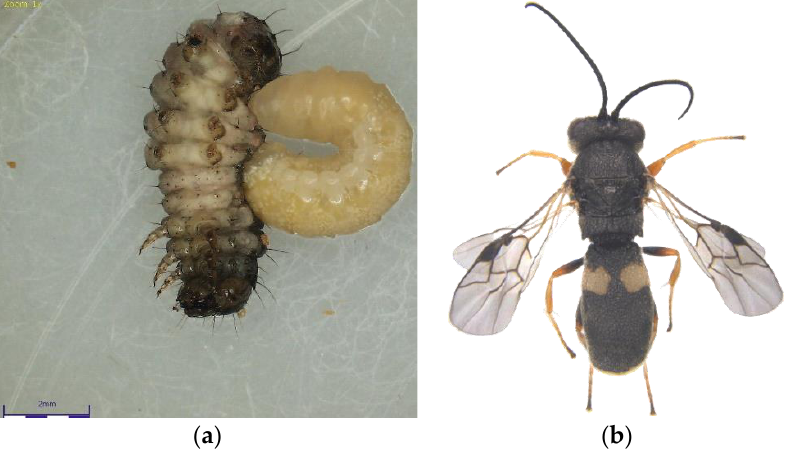
Figure 2. ( a ) Chelonus formosanus larva emerging from the Fall Armyworm larvae; ( b ) C. formosanus adult. Table 2. Percentage of Fall Armyworm egg mass parasitized by Trichogramma chilonis and Telenomus remus Table 1. Relative abundance and parasitism rate of native parasitoids on S. frugiperda in New Delhi, India.